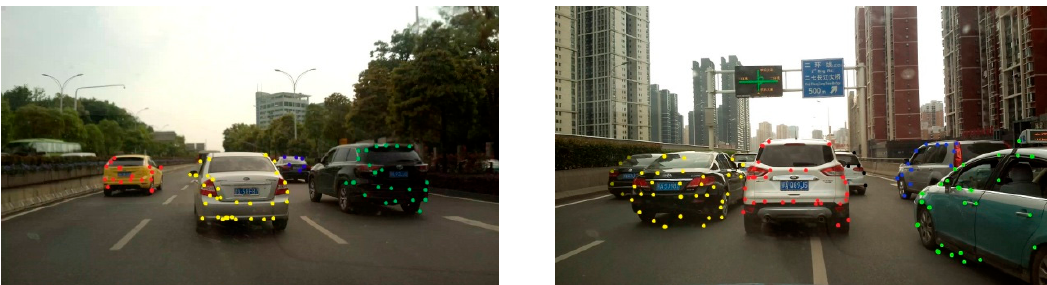
Figure 7. Clustering of motion vectors.